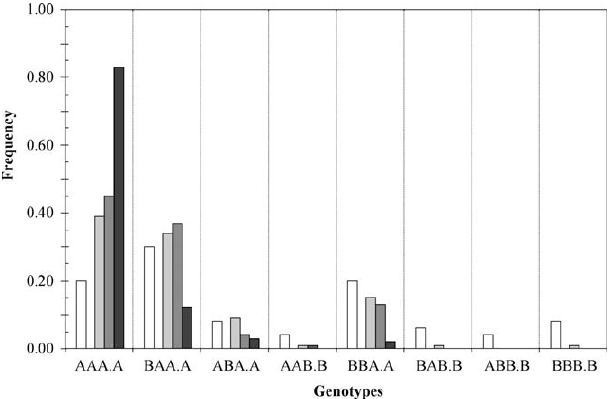
Figure 2. Variation of Genotype Frequencies in Pooled Progenies from Double Inoculations of IA and IB CMV Isolates Frequencies in TIL (black box), VIL (dark-gray box), and TSL (light-gray box) progenies are compared to those of LLH (white box) progenies. doi:10.1371/journal.ppat 0030008.g002